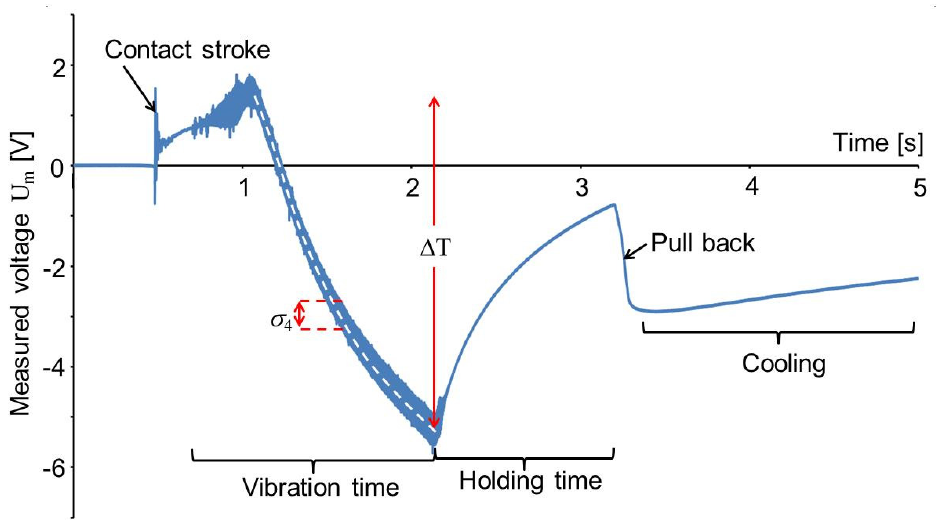
Figure 10. Voltage measured as a function of time by a PVDF sensor foil in a linear friction welding machine.